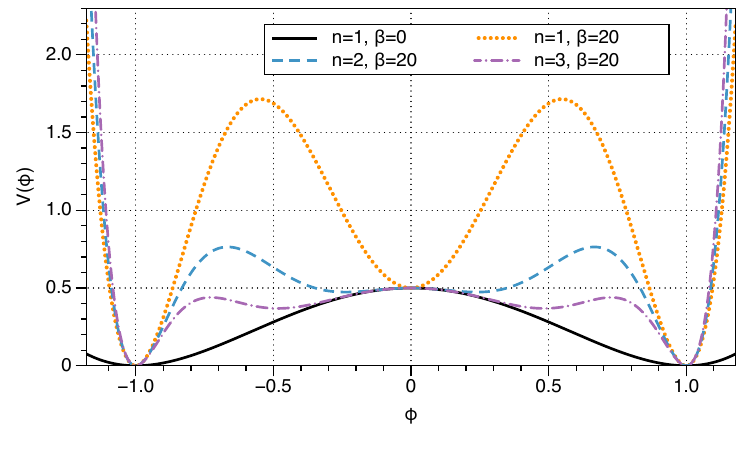
Figure 1 . The scalar potential V ( (cid:30)